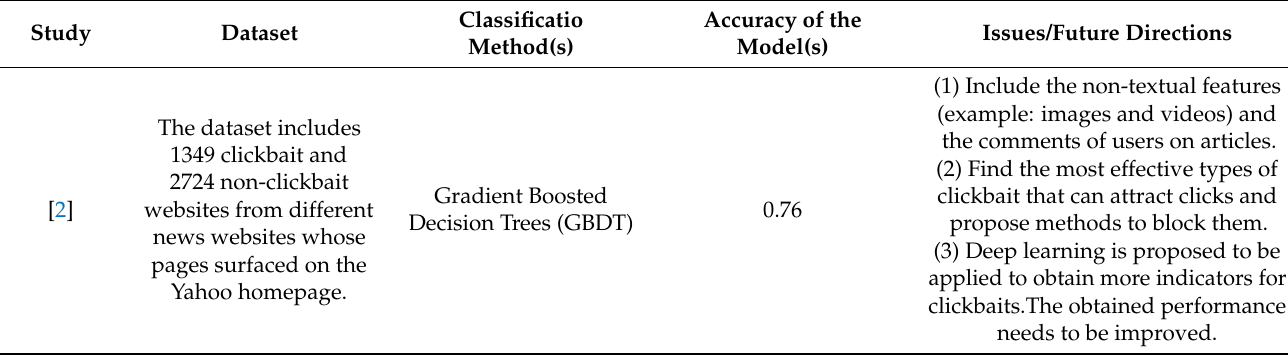
Table 1. Summary of recent studies on clickbait detection